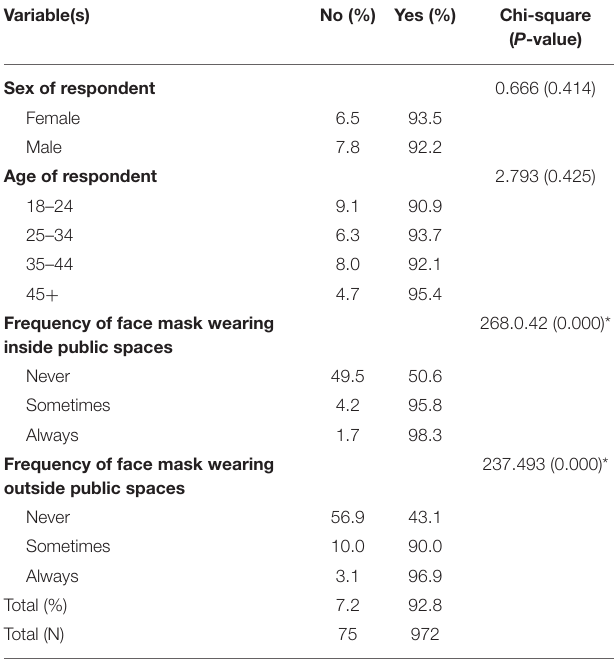
TABLE 2 | Relationship between selected variables and whether wearing a face mask inside public spaces can prevent COVID-19